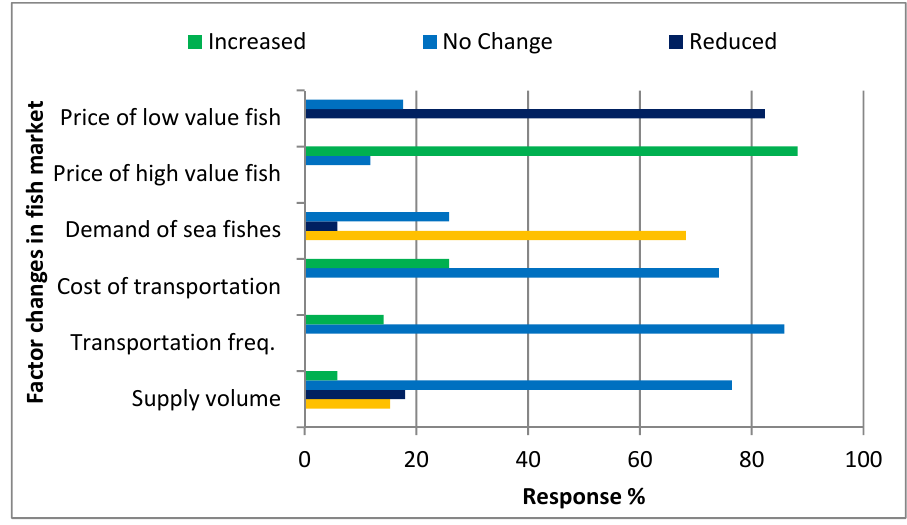
Figure 4. Perception of impacts of COVID-19 on retailer fish market.